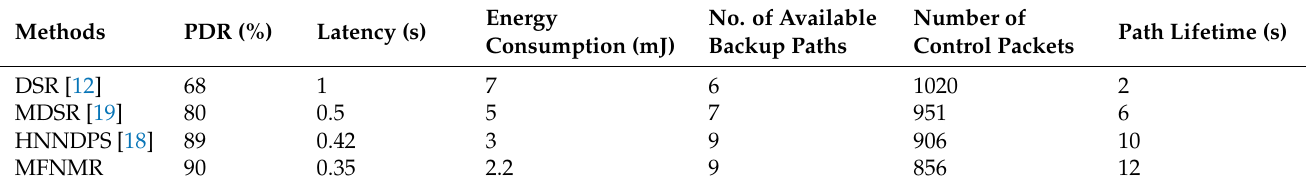
Table 3. Performance analysis of DSR, MDSR, HNNDPS and